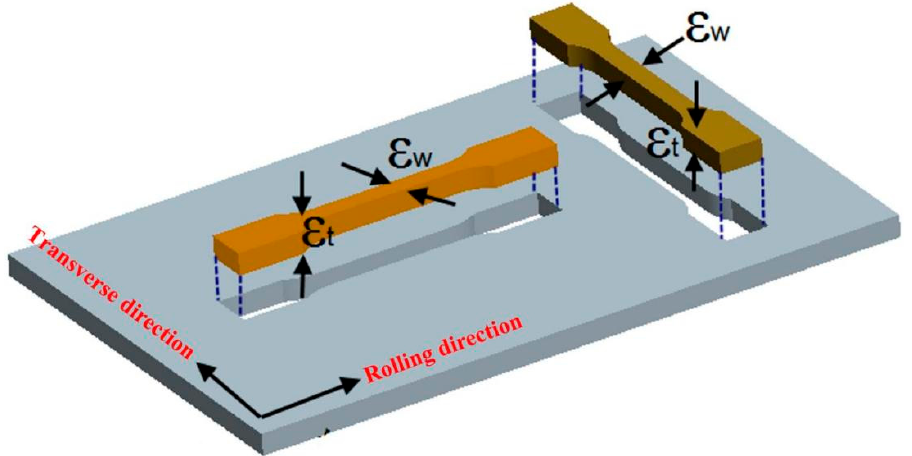
indicates the strain ratio along the ε indicate the strain along the width and thickness t